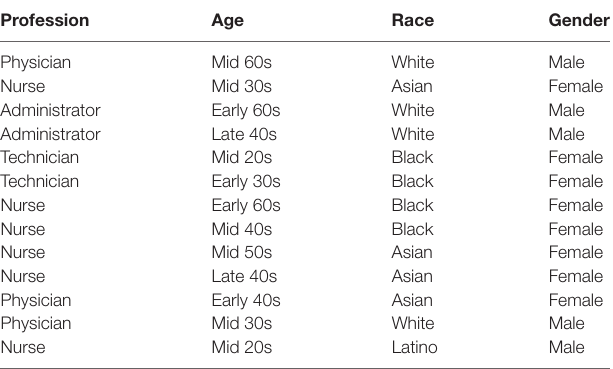
TaBle 1 | Profession, age, race, and gender of interviewees.